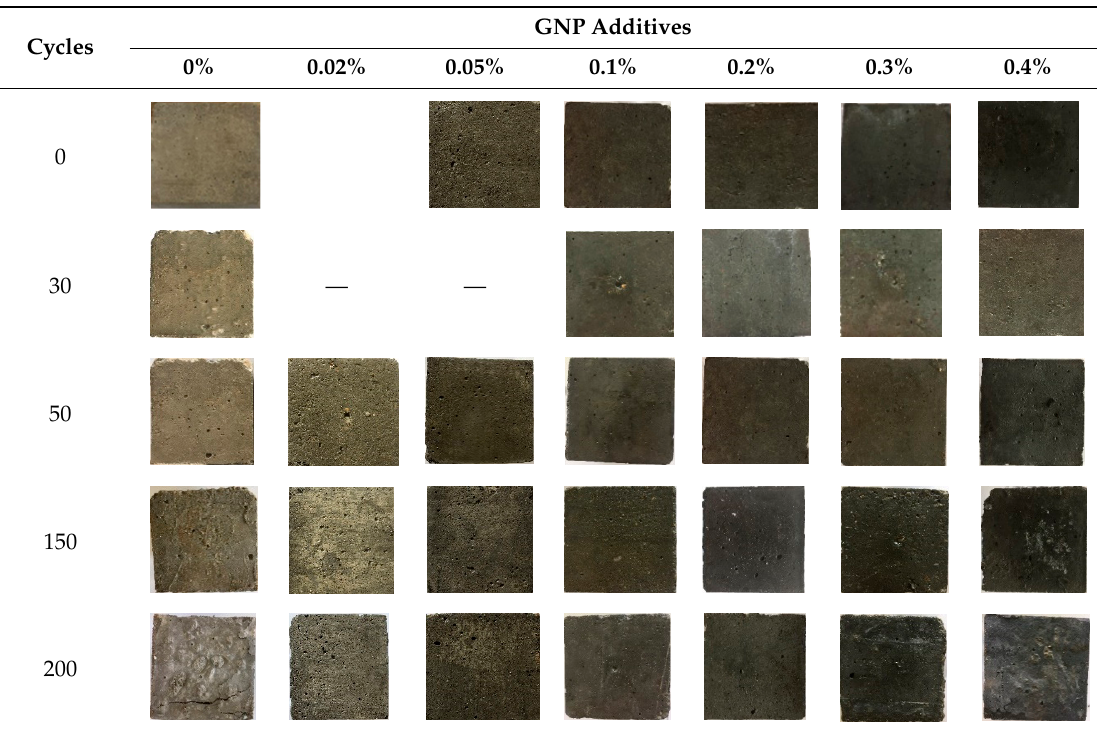
Table 2. Visual observations of GNP concrete at different F-T cycles.